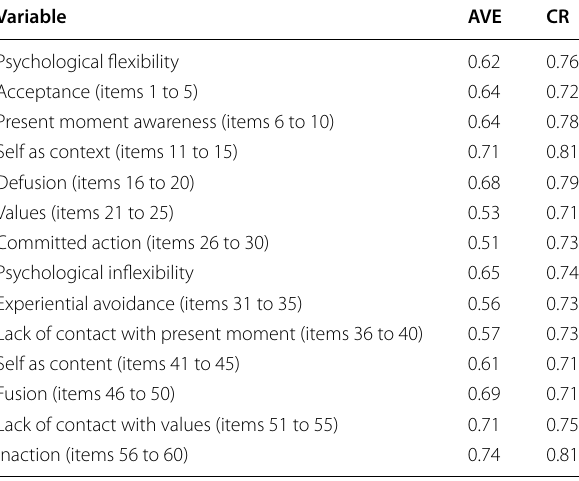
Table 3 AVE and CR for twelve subscales of psychological